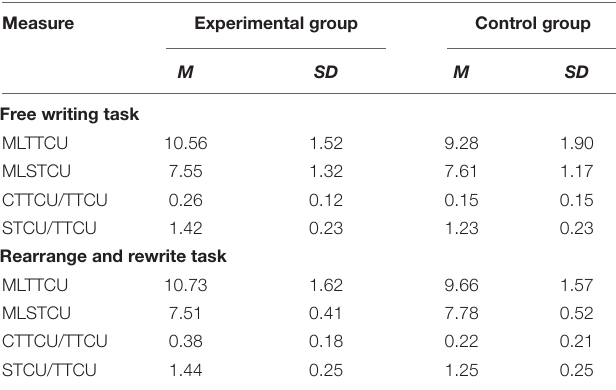
M, mean value; SD, standard deviation; MLTTCU, mean length of terminable TC- unit; MLSTCU, mean length of single TC-unit; CTTCU/TTCU, complex terminable TC-unit in all terminable TC-units; STCU/TTCU, single TC-units per terminable TC- unit; correct, scores of deletion